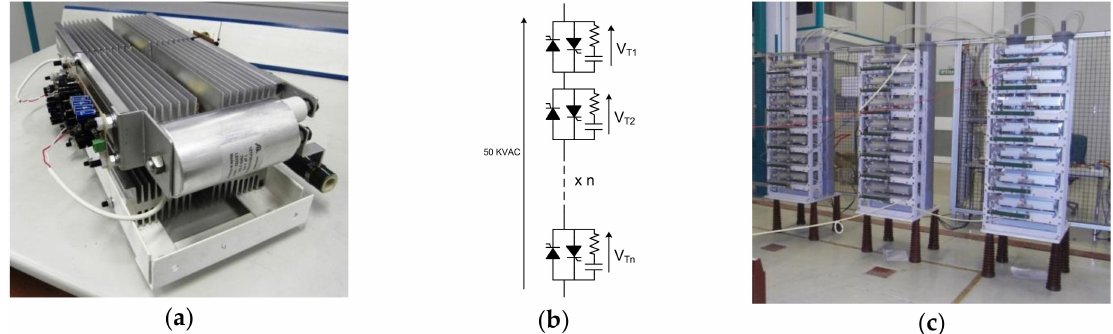
Figure 4. ( a ) Basic module of AC static switch; ( b ) electric scheme of 50 KVAC static switch with n = 21; ( c ) 50 KVAC static switch composed of three stacks of seven basic